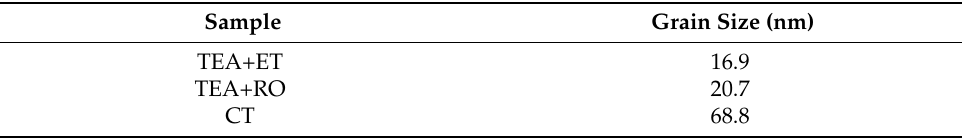
Figure 2. ( A ) XRD patterns of three groups of samples and standard XRD cards of HAP. ( B ) FTIR spectra of three groups of samples. Table 5. Grain size of each experimental group calculated from XRD